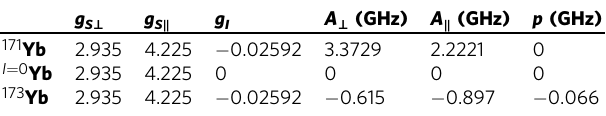
Fig. 5 Evolution of the spin – photon rates with temperature. a Experimental (dots) and theoretical (lines) coupling rates as a function of temperature for the three electronic spin transitions coupled to a f r = 414.3 MHz cavity. b Experimental (dots) and theoretical (lines) coupling rates as a function of temperature for different nuclear spin transitions in [ 173 Yb(trensal)]. Here, the 0, 1 transition resonates at f r = 548.5MHz, while the others are measured with the same 414.3 MHz cavity as the electronic spin transitions shown in a . Errors have been determined from the Jacobian matrix obtained from the fi ts to Eq. (4).